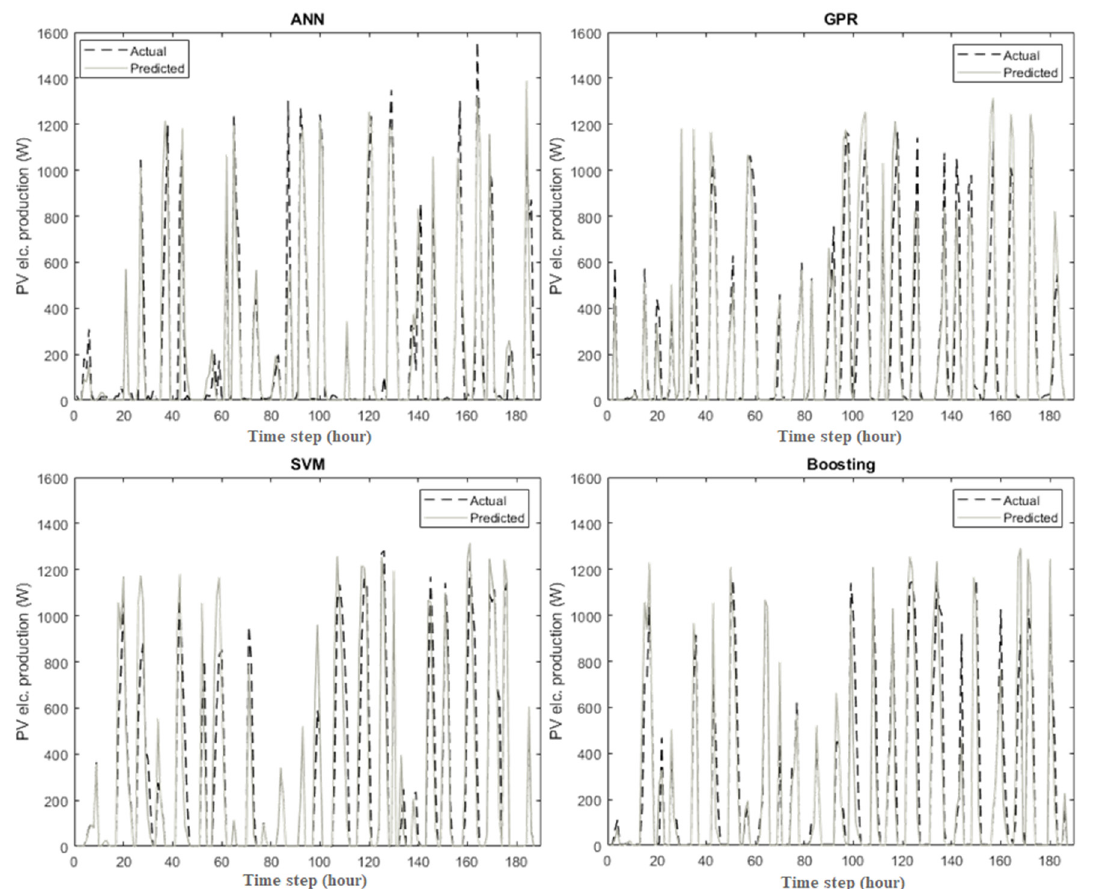
Figure 8. Measured and predicted PV module electrical production for the month of March (validation set).